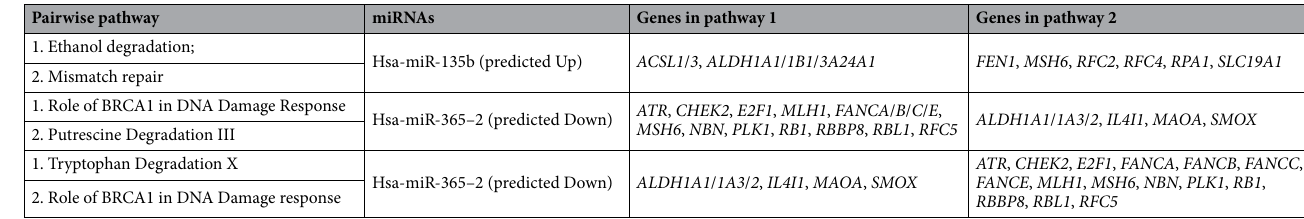
Table 1. List of genes controlled in coupled pathways by the selected two